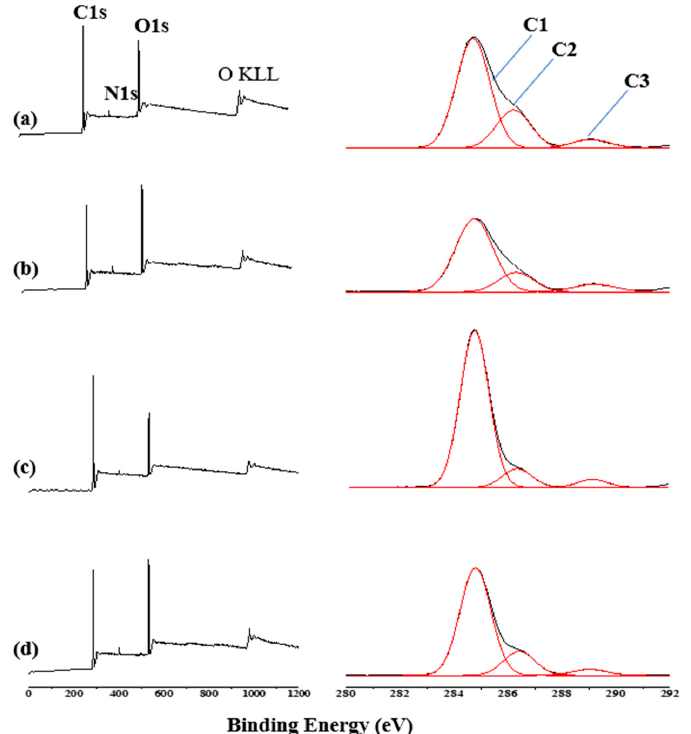
Figure 6. The static water CA measurements on upper and inside surfaces of three films: ( a ) upper surfaces of 23 wt.% Endo-L-Borneol acrylate; ( b ) upper surfaces of 37 wt.% Endo-L-Borneol acrylate; ( c ) upper surfaces of 54 wt.% Endo-L-Borneol acrylate; ( d ) inside surfaces of 23 wt.% Endo-L-Borneol acrylate; ( e ) inside surfaces of 37 wt.% Endo-L-Borneol acrylate; ( f ) inside surfaces of 54 wt.% Endo-L-Borneol acrylate.